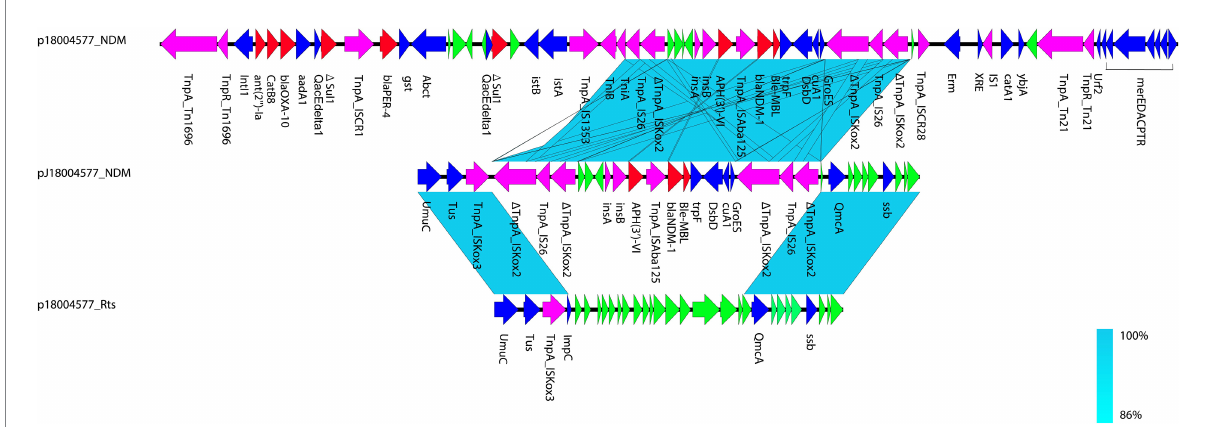
FIGURE 1 Comparison of p18004577_NDM, pJ18004577_NDM, and p18004577_Rts. Colors of the arrows indicate the functions of the predicted ORFs: accessory genes (blue), antimicrobial resistance genes (red), transposon-related genes and insertion sequences (purple), and hypothetical proteins (green). Regions with homology are shaded light